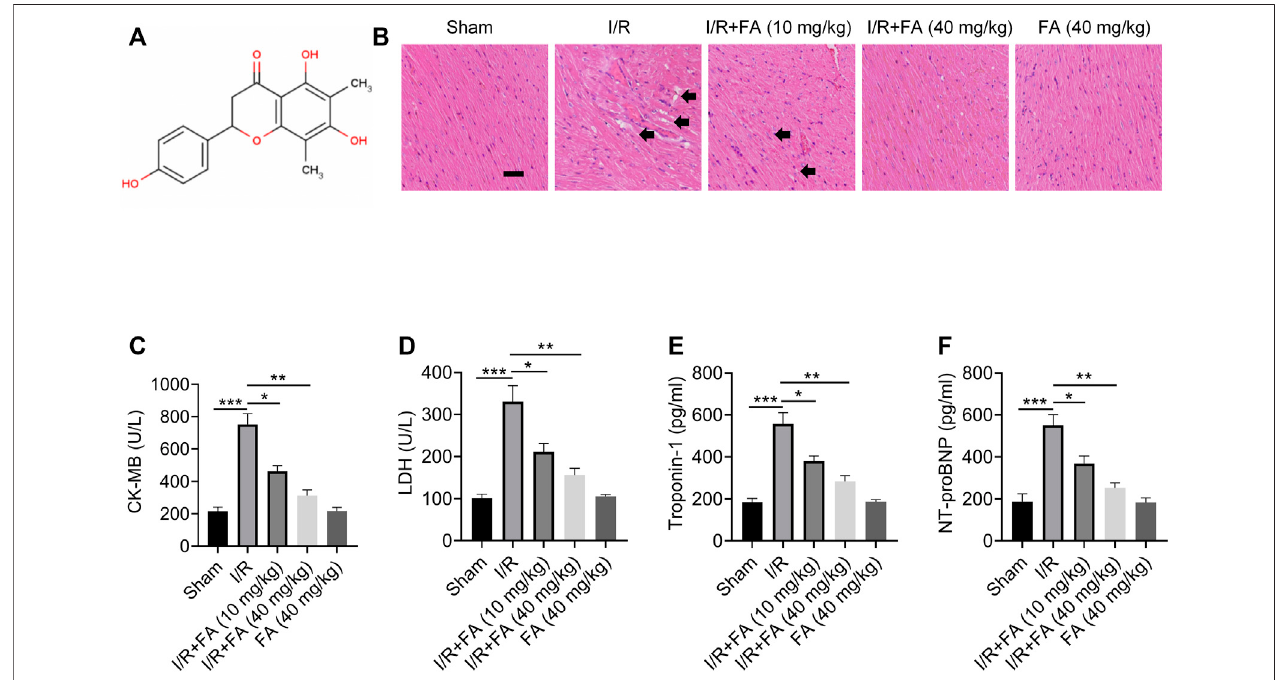
FIGURE 1 | The protective effect of FA against I/R-induced myocardial injury in mice. (A) Chemical structural formula of FA. (B) HE staining results of heart tissue sections in each experimental group of WT mice. (C – F) Expression of CK-MB, LDH, troponin-1, and NT-proBNP in the serum in each experimental group of WT mice, detected by ELISA. Data are expressed as the means ± sd from three independent experiments. * p < 0.05, ** p < 0.01, and *** p <